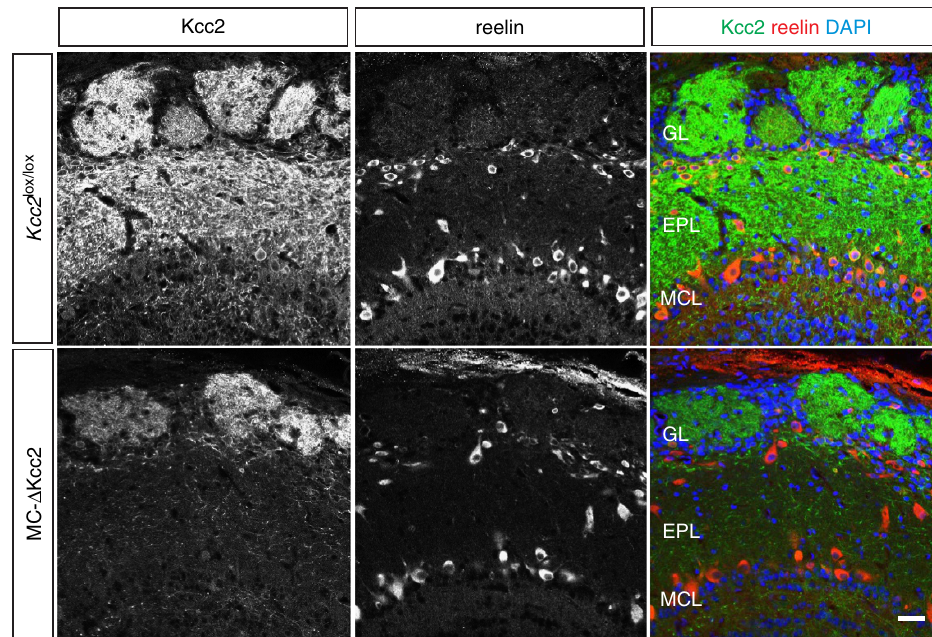
Figure 1 | Cell-type specific deletion of Kcc2 in mitral/tufted cells within the main OB. Immunofluorescent staining of Kcc2 (green) and mitral cell marker reelin (red) of coronal sections of the main OB from 5-week-old MC- D Kcc2 mice compared with Kcc2 lox/lox littermates. Nuclei were stained with DAPI (blue). Scale bar, 30 m m. EPL, external plexiform layer; GL, glomerular layer; MCL, mitral cell